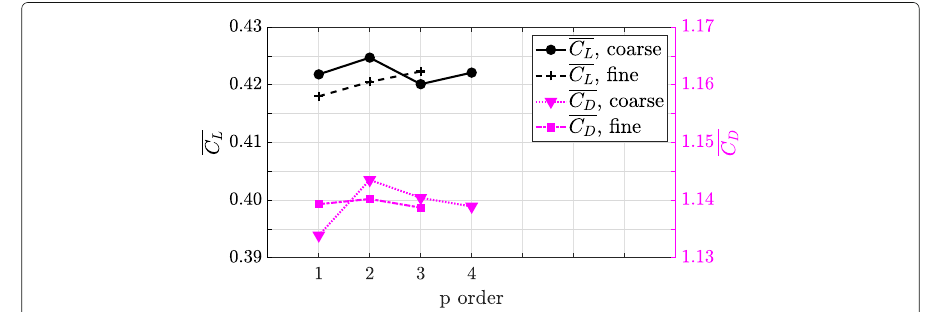
Fig. 3 Convergence of the mean lift C L and drag C D